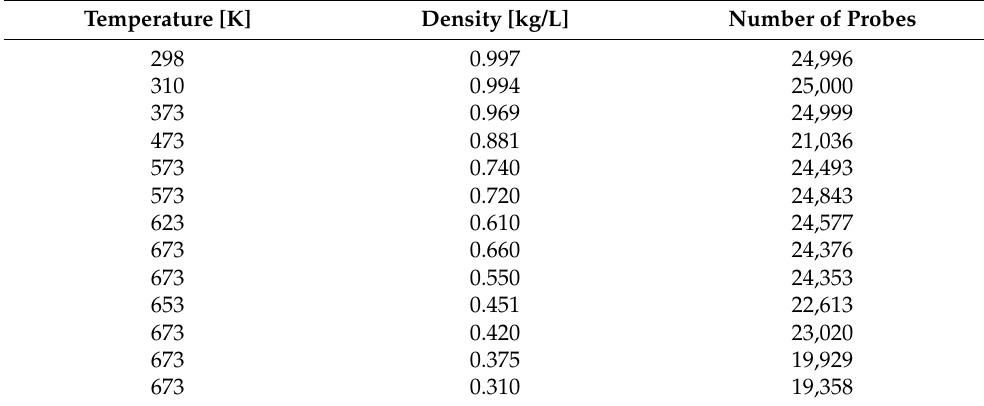
Table 1. The parameters of the simulated solutions of the hydroxyl radical in water: temperature, density, and the number of configurations analyzed for each thermodynamic